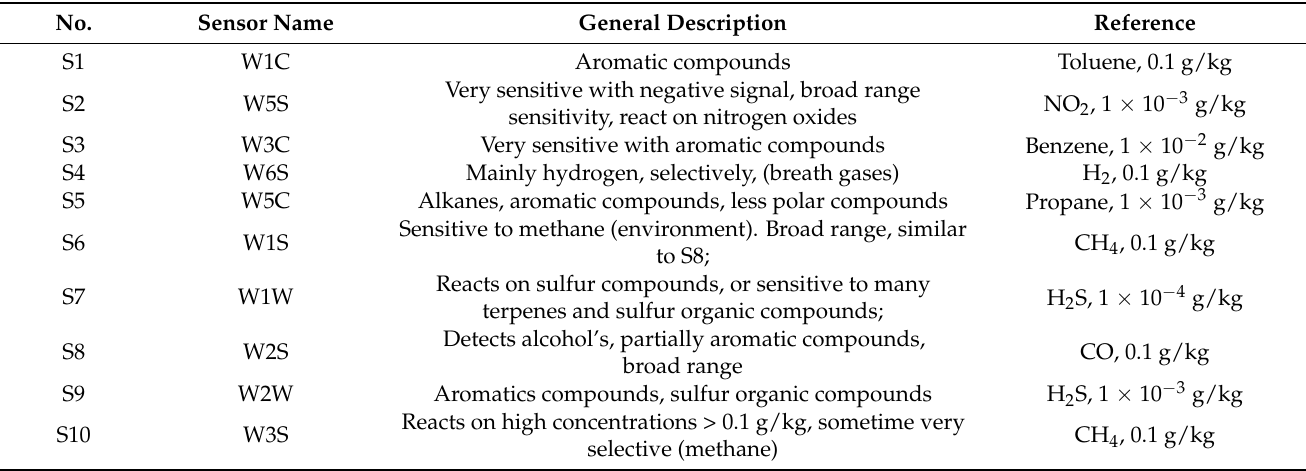
Table 1. Sensors used and their main applications in the